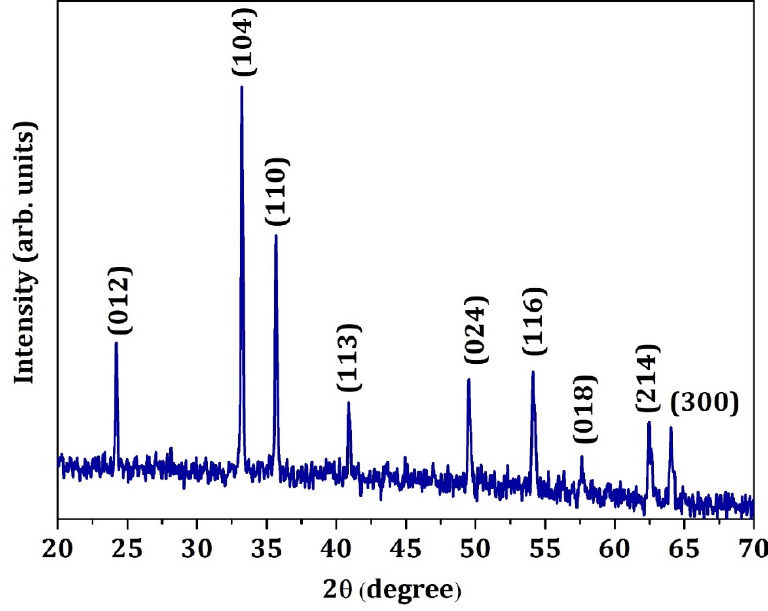
Figure 1. Powder XRD pattern of α‐ Fe 2 O 3 prepared by solution